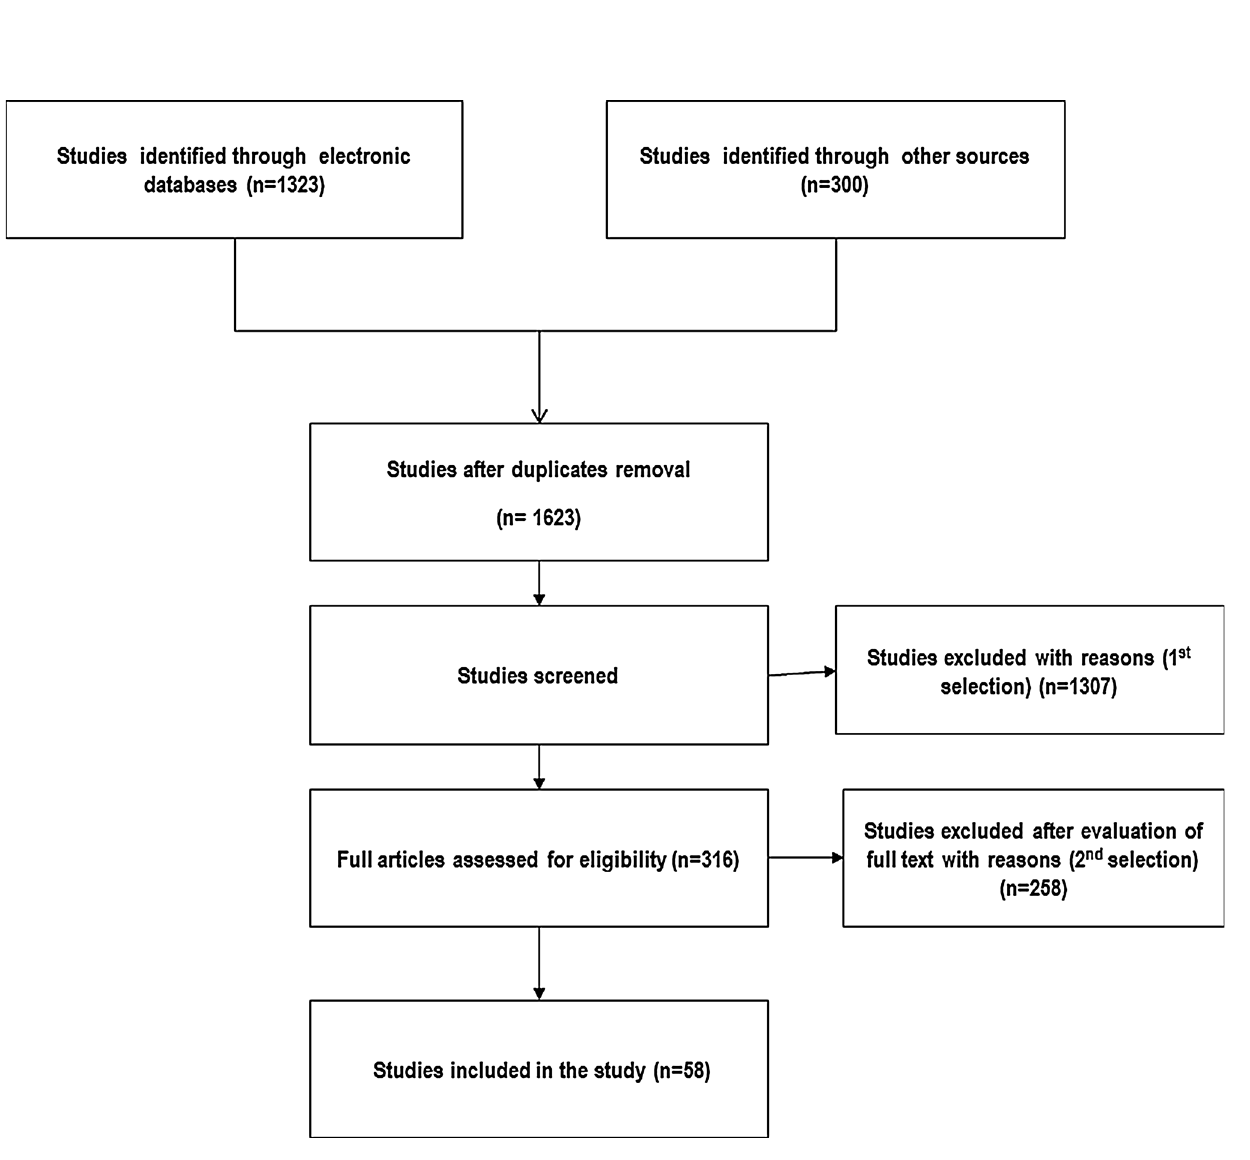
Fig. 1 Studies selection flow